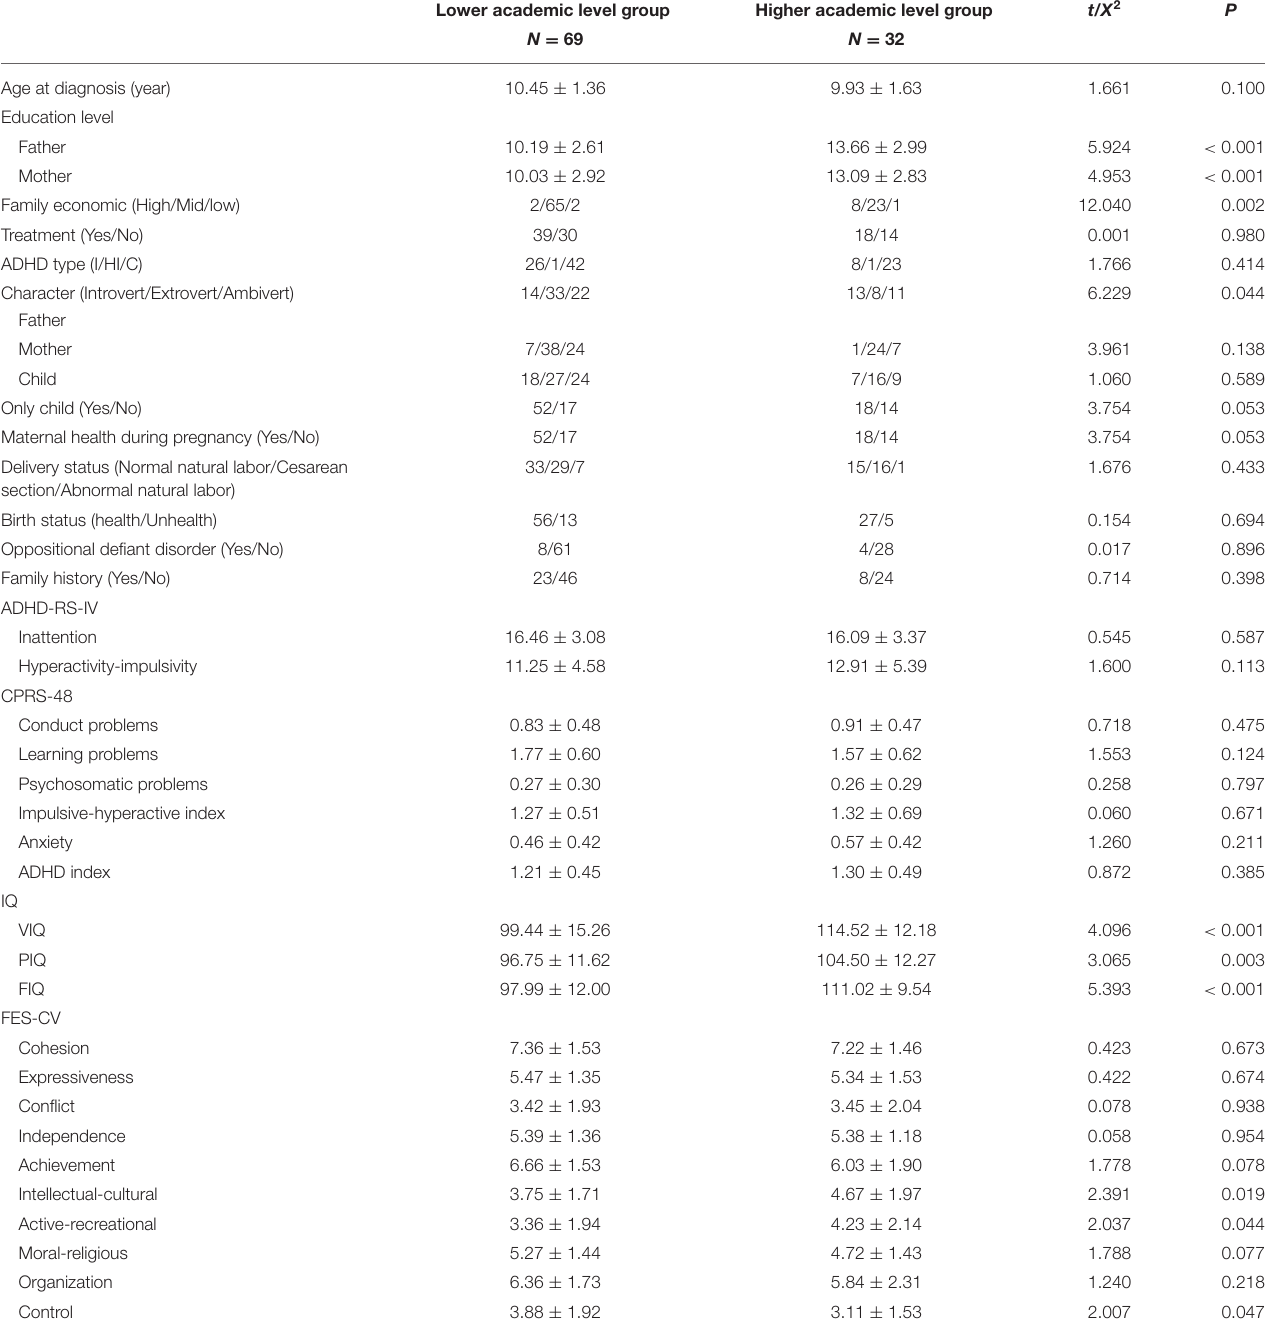
TABLE 3 | Comparisons of childhood characteristics between different academic